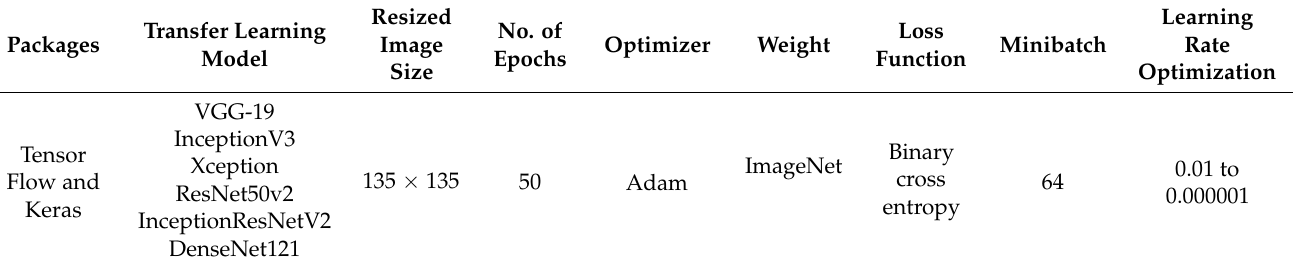
Table 3. Training and validation parameters of the six-transfer learning deep CNN